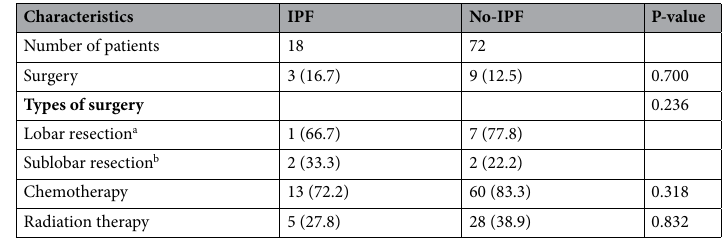
Table 4. Comparison of treatment of SCLC between the IPF and no-IPF groups. Data are presented as number (%), unless otherwise indicated. SCLC small cell lung cancer, IPF idiopathic pulmonary fibrosis. a Lobar resection: lobectomy or more extensive resection (bilobectomy or pneumonectomy). b Sublobar resection: segmentectomy or wedge resection.